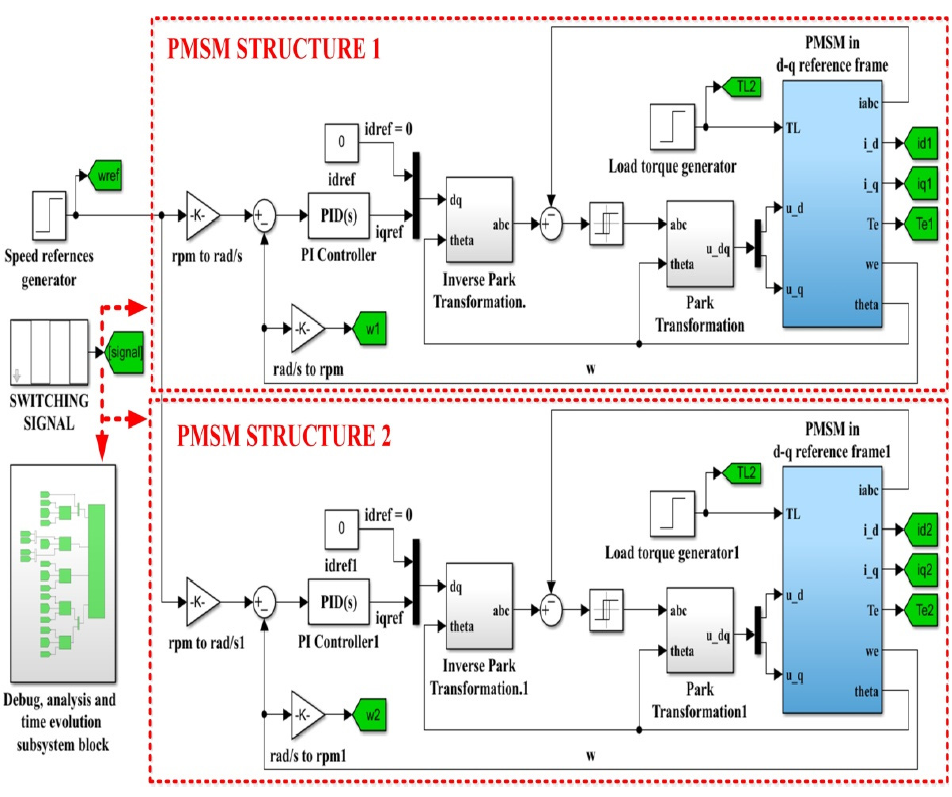
Figure 10. Simulink implementation for PMSM control system based on FOC-type strategy for PMSM variable structure with switching signal type 1.